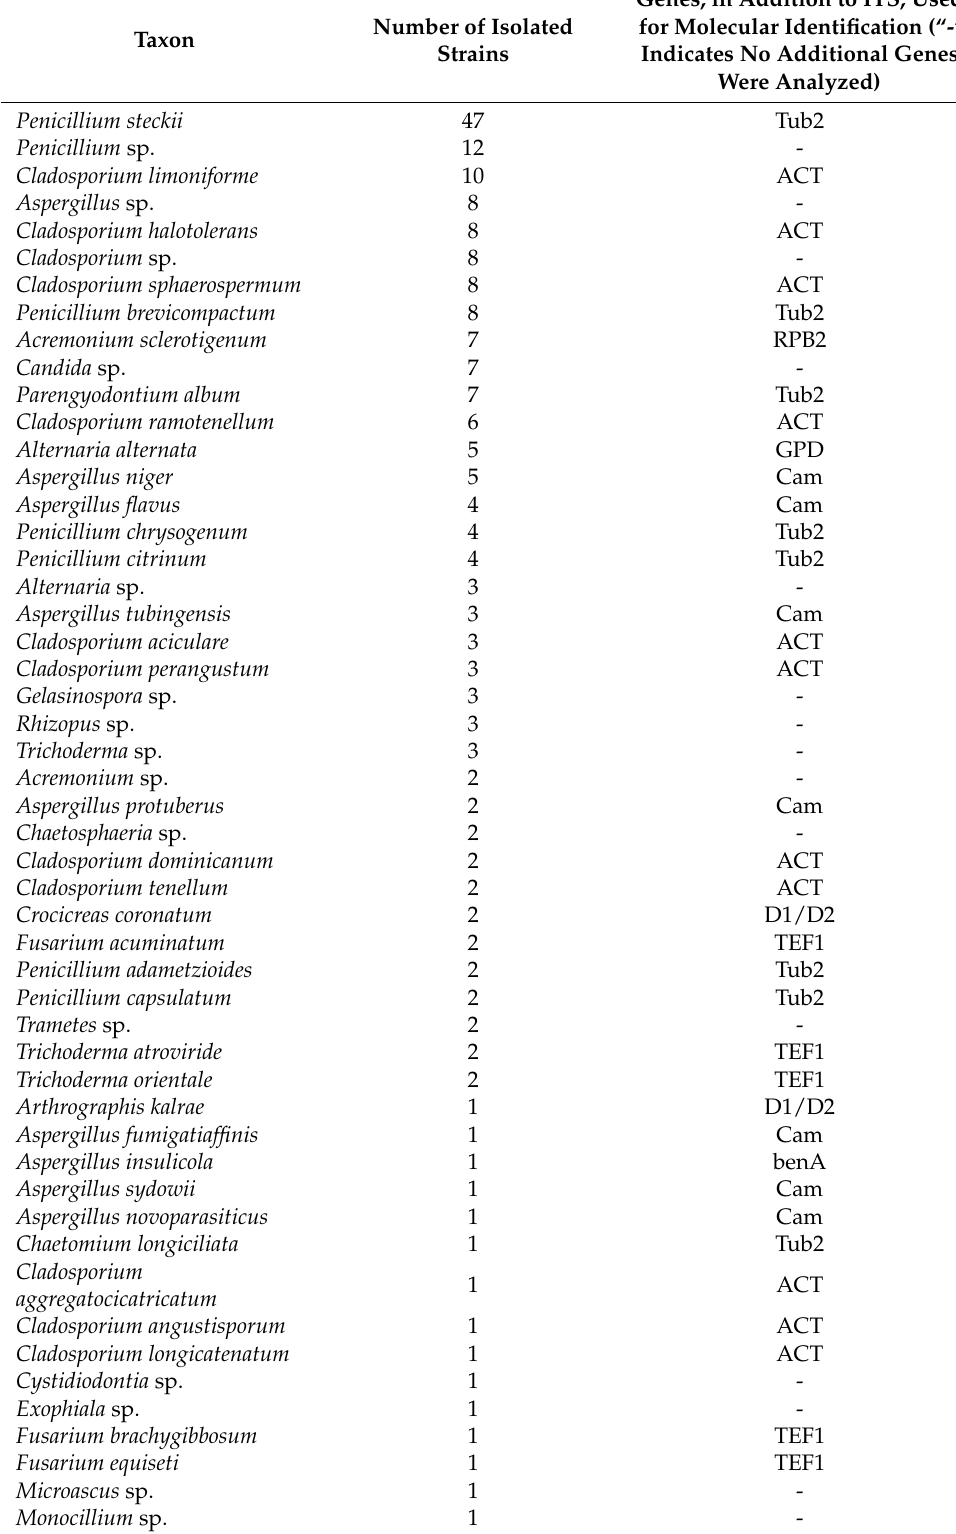
Table 2. Fungal taxa found in association with Agelas oroides